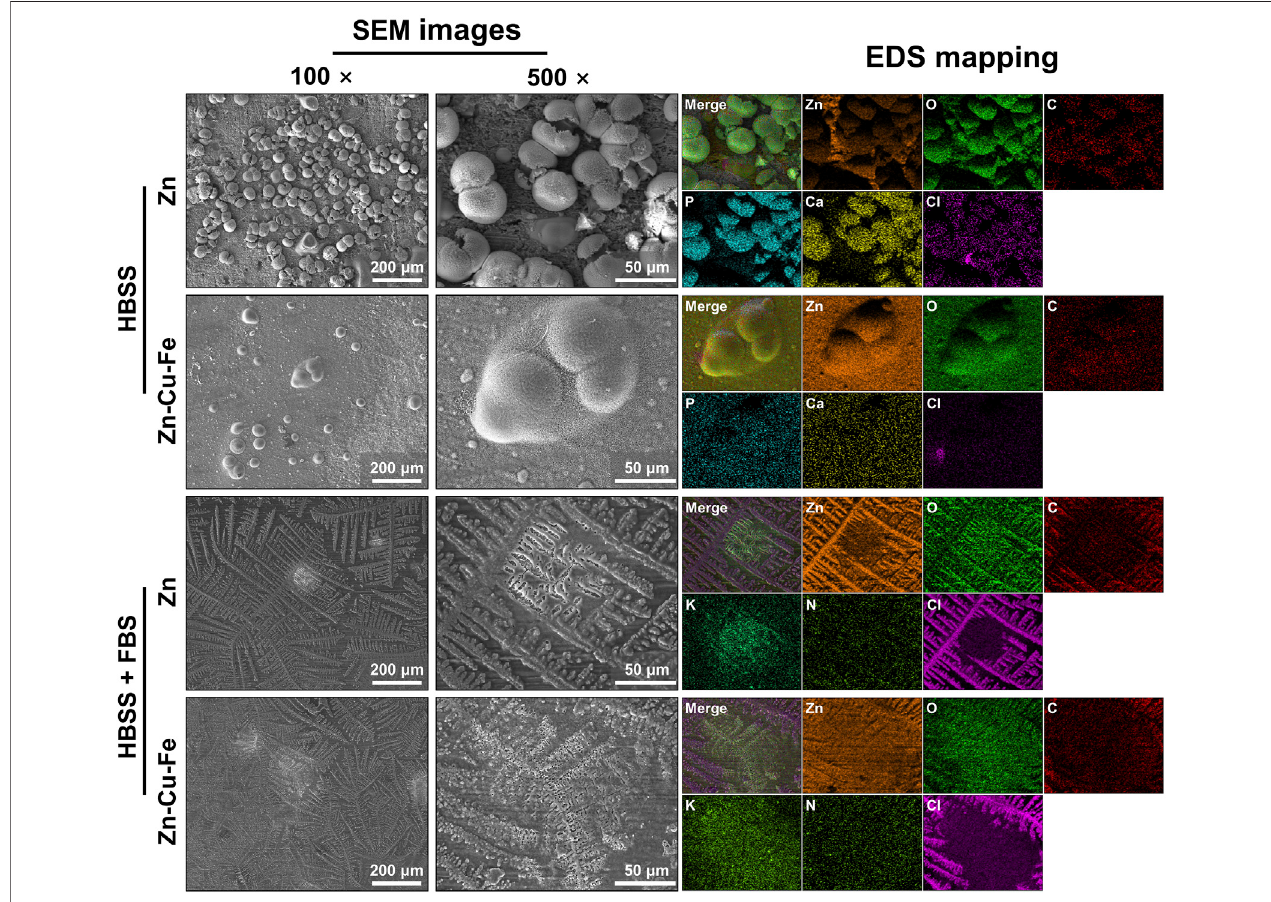
FIGURE 2 | Surface characterization of pure Zn and Zn-Cu-Fe alloy after immersion in HBSS with or without FBS under cell culture conditions for 21 days. RepresentativeSEMimagesshowdegradationproductsonthesurfacesaftertheimmersiontest(magni fi cation:100×and500×)at15 kV.TheresultsofEDSmapping indicate the elemental composition of degradation